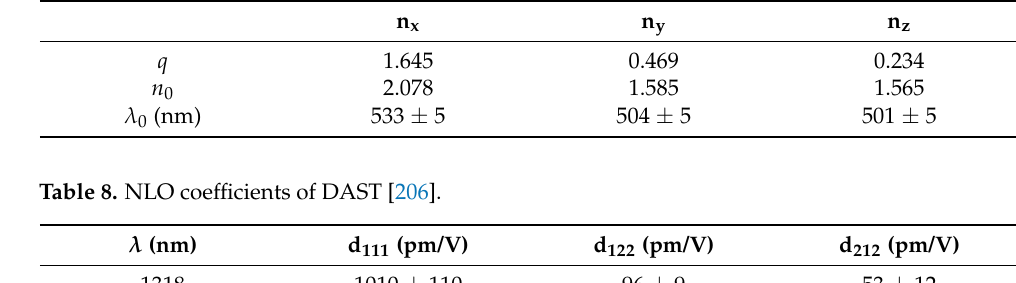
Table 7. Sellmeier parameters for the refractive index dispersion of Equation (23) [93].